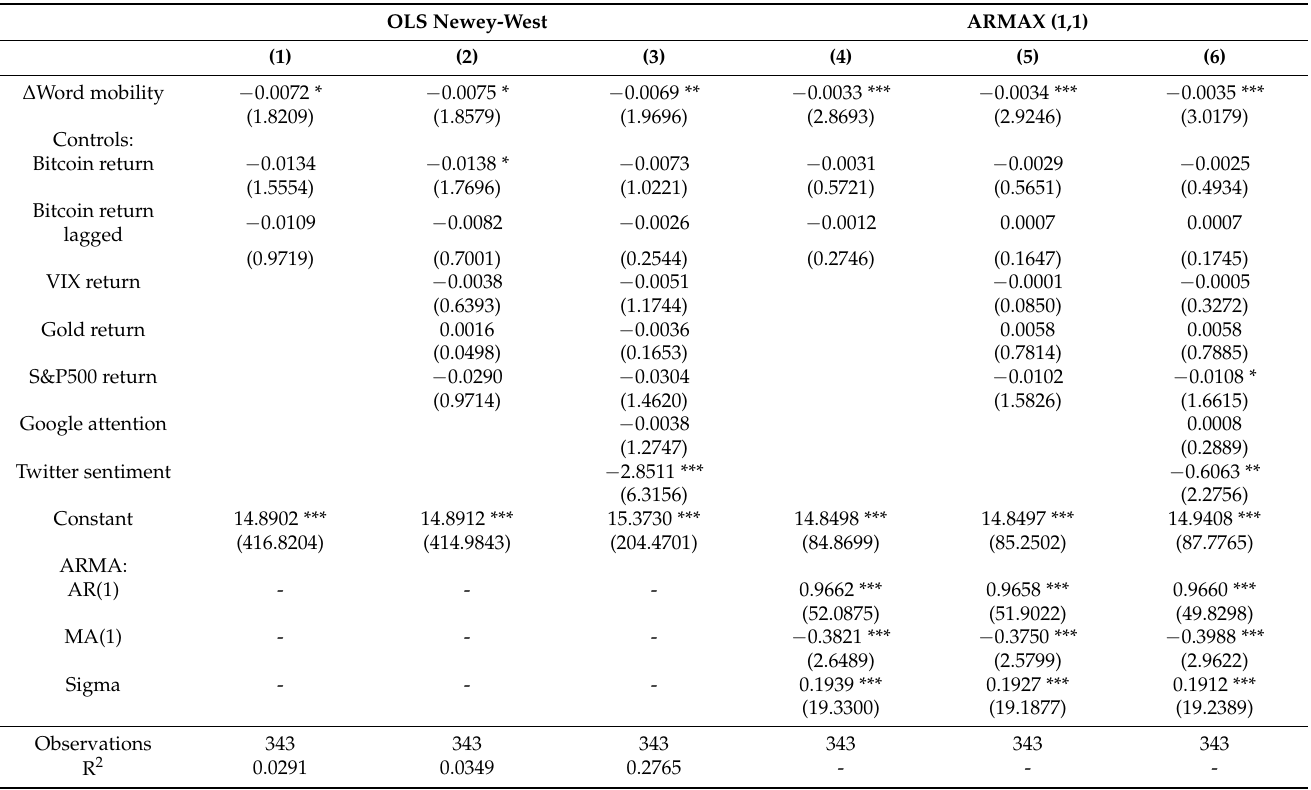
Table 2. The impact of mobility on Bitcoin trading